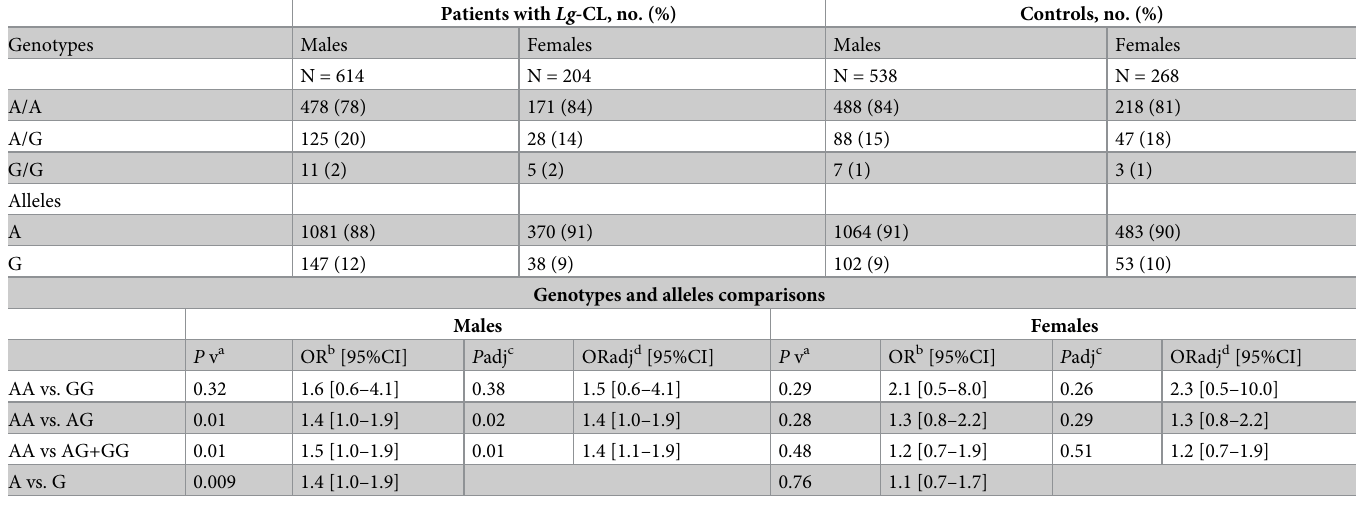
Table 3. Distribution and Comparison of Genotypes and Alleles frequencies of the MIR499A rs3746444 between Patients with Leishmania guyanensis -Cutaneous Leishmaniasis ( Lg -CL) and Controls stratified according to gender. Patients with Lg -CL, no.